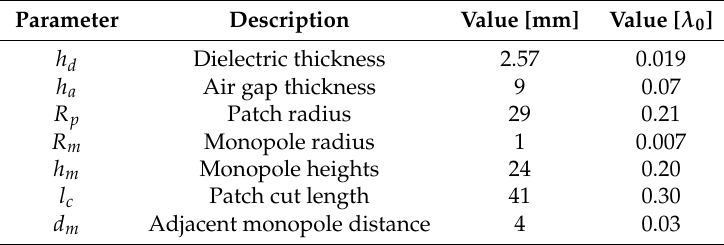
Table 3. The 2-by-2 array geometric parameters ( f = 2.2